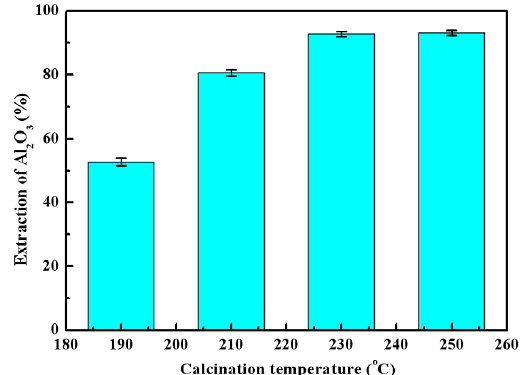
Figure 3. E ff ects of calcination temperature on alumina extraction from CFA at a reaction time of 3 h and KHSO 4 / Al 2 O 3 molar ratio of